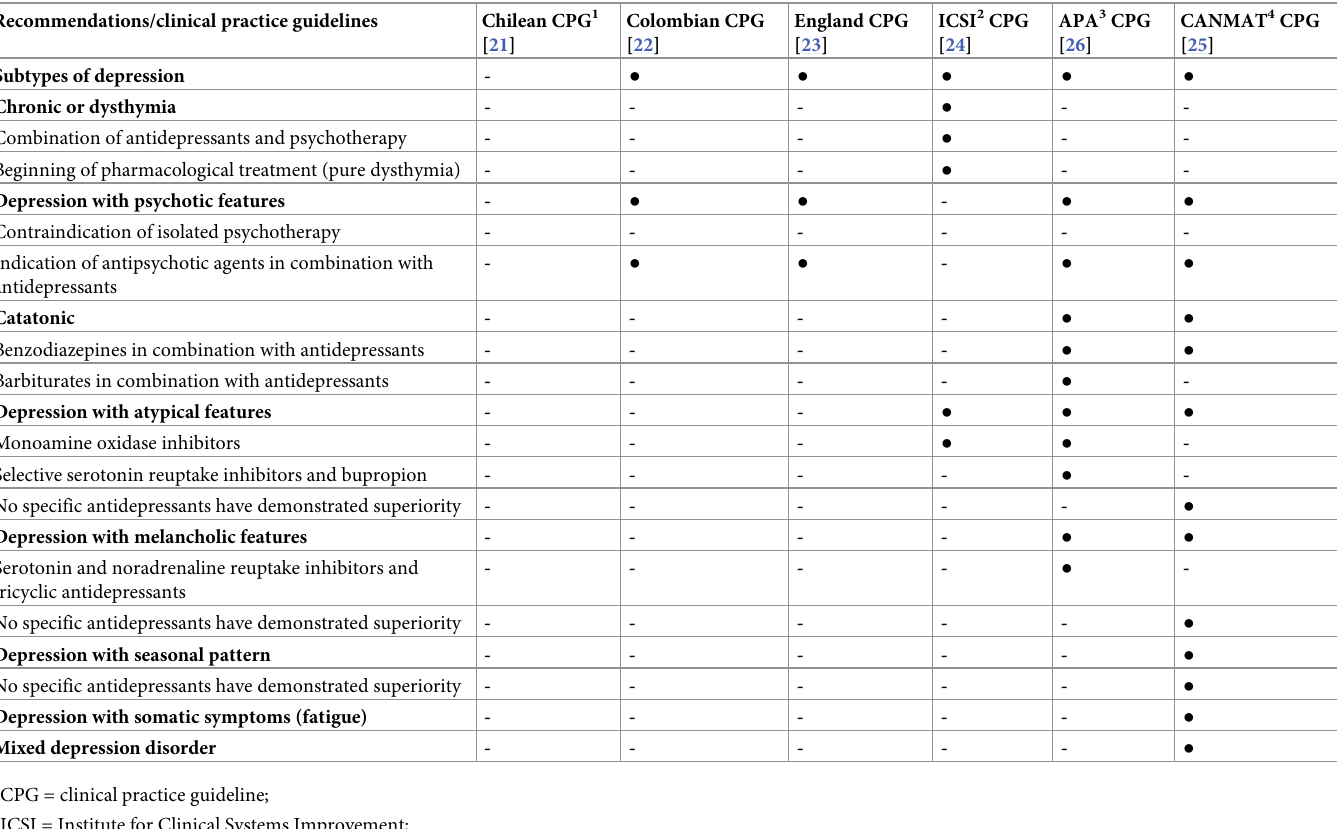
Table 4. Clinical practice guidelines for the pharmacological treatment of depression: Subtypes of